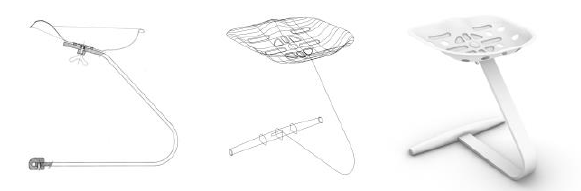
Figure 4. Workflow for modeling the design objects